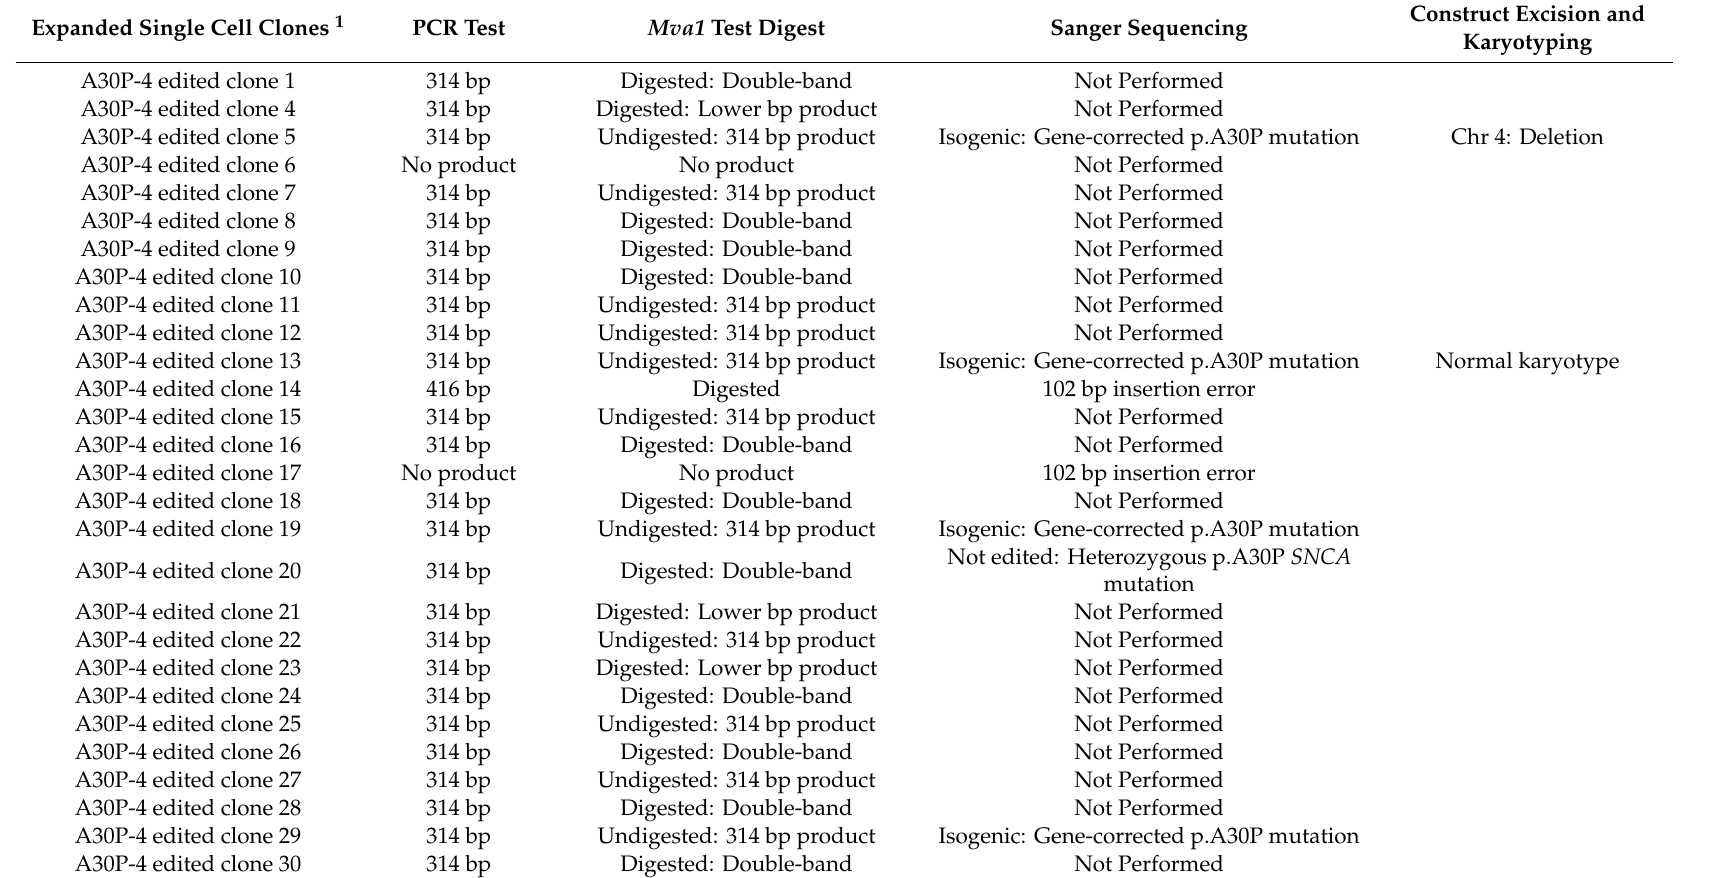
Table 1. List of CRISPR-Cas9 mediated single-cell isogenic patient-derived iPSC clones generated in this study with cell line validation criteria. Expanded Single Cell Clones